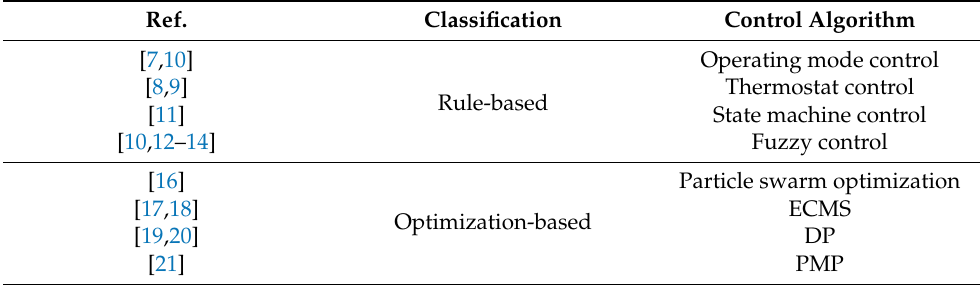
Table 1. The summary of strategies.